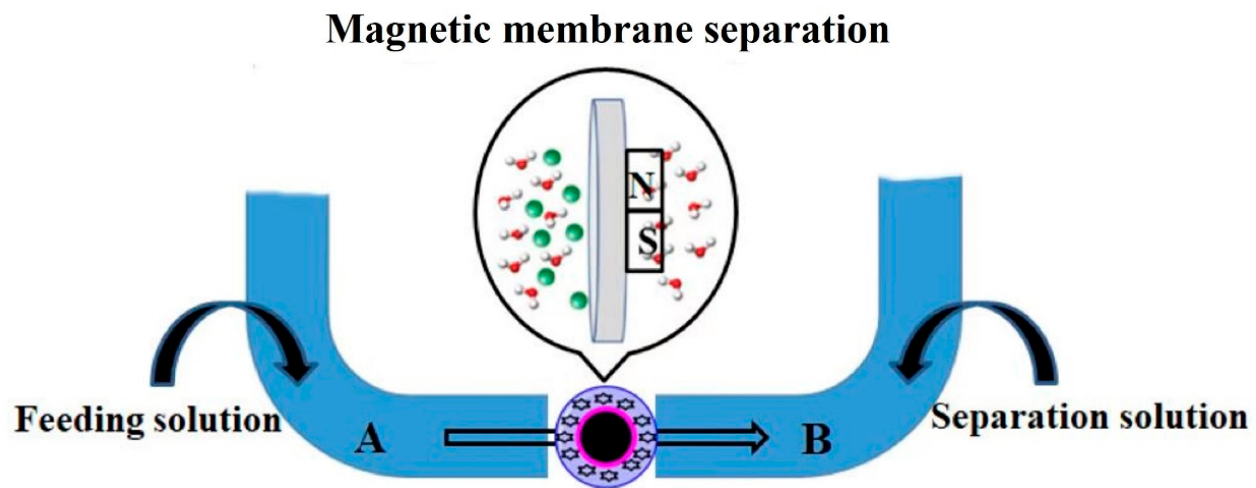
Figure 1. Schematic diagram of the magnetic membrane separation procedure.